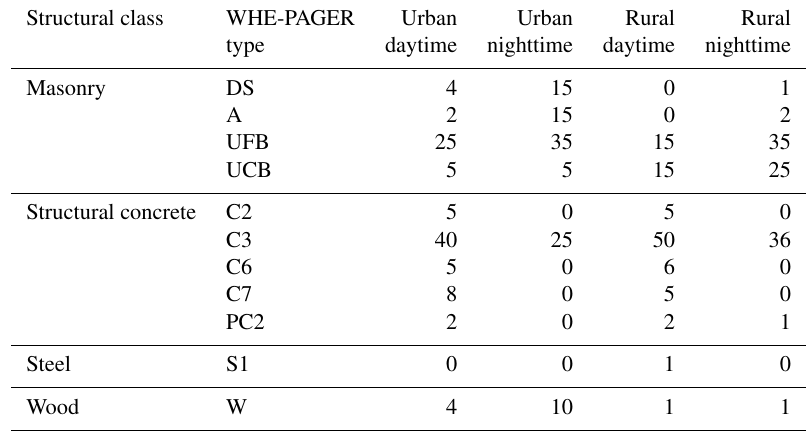
Table 3. Building occupancy percentages by structural type and time of day, from Jaiswal and Wald (2009b). Structural class WHE-PAGER Urban Urban Rural Rural type daytime nighttime daytime nighttime Masonry DS 4 15 0 1 A 2 15 0 2 UFB 25 35 15 35 UCB 5 5 15 25 Structural concrete C2 5 0 5 0 C3 40 25 50 36 C6 5 0 C7 8 0 PC2